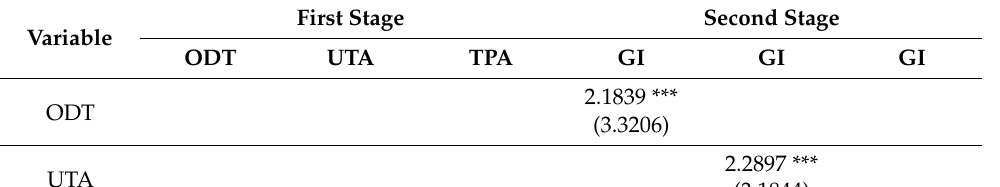
Table 14. Test results of instrumental variable